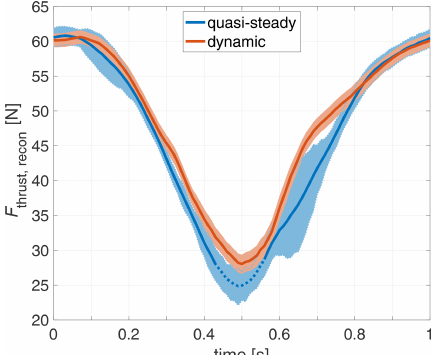
Figure 10. Thrust force reconstructed for the quasi-steady exper- iment and dynamic experiment from u ax ( t ) and u ta ( t ) for the sine wind variation. Quasi-steady u ta ( t ) is used for both cases due to the low impact. Error bars are based on the quadratically added 95% confidence intervals. Dotted values indicate the extrapolated char-